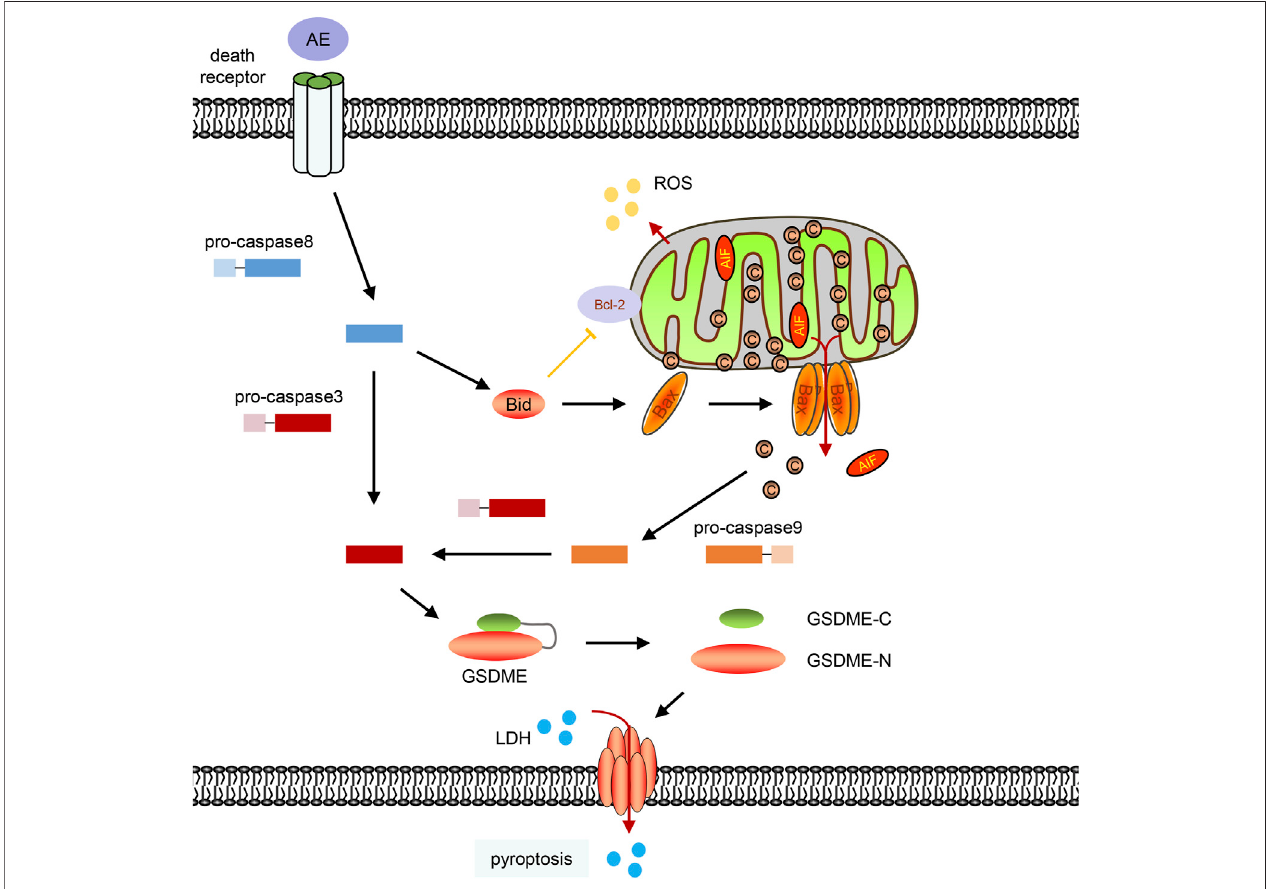
FIGURE 7 | A schematic diagram of this work. Aloe-emodin can induce caspase-8 activation, Bid cleavage, BAX translocation to permeabilize the mitochondrial membrane and release cytochrome c into the cytosol. Cytochrome c then activates caspase-9 and subsequent caspase-3. Active caspase-3 mediates the GSDME cleavage, and GSDME-N could directly oligomerize and cause plasma membrane lysis which will cause pyroptosis characteristics, including LDH release and the formation of plasma membrane bubbles.